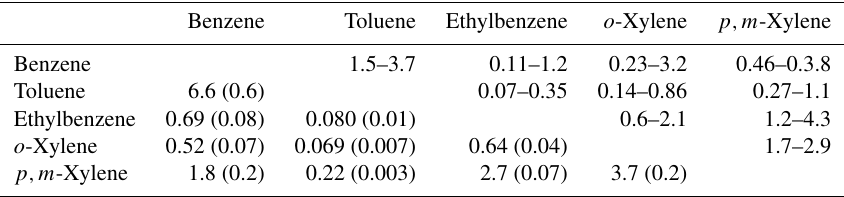
Table 5. Ratios of VOC mixing ratios. Values below the diagonal are the ratios for the measurements presented in this work a , values above the diagonal give the range of ratios observed in literature b .